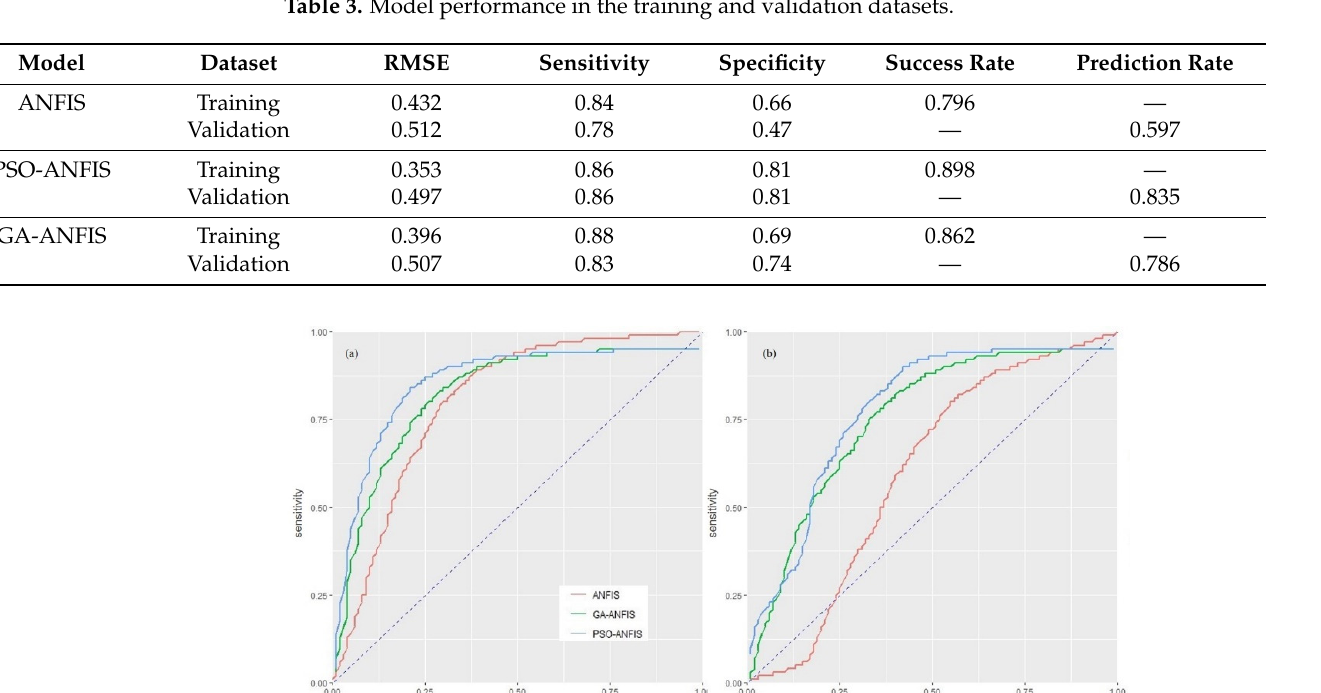
Table 3. Model performance in the training and validation datasets.